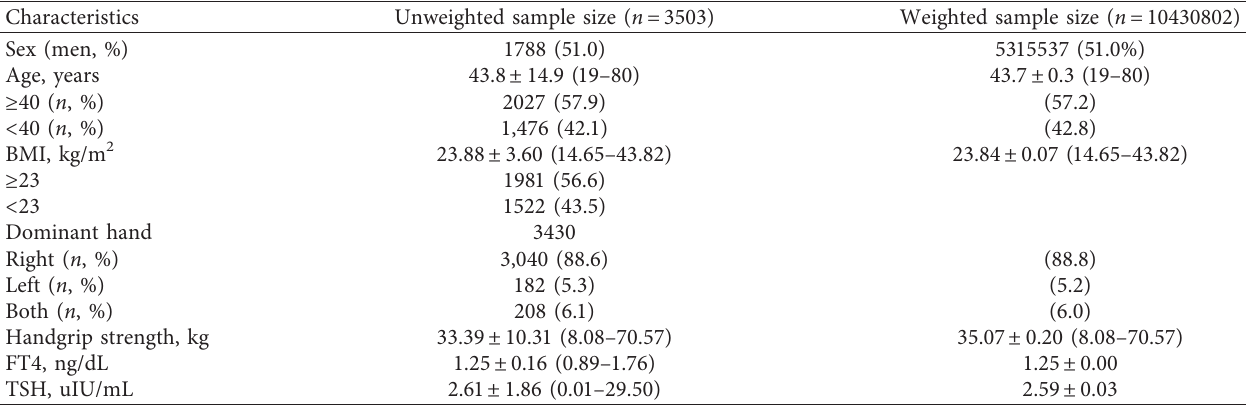
Table 1: Baseline